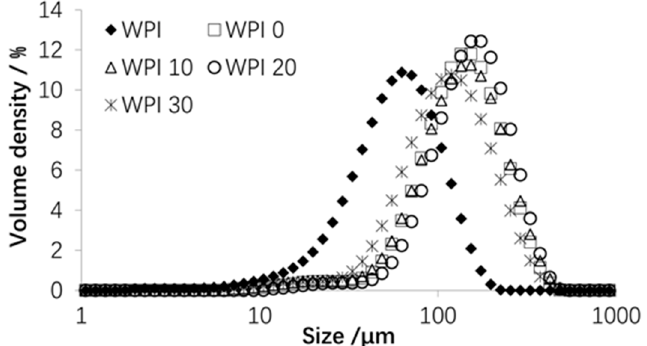
Figure 2. Particle size distributions of original and agglomerated WPI powders. Table 1. Particle size, densities and porosity of the original WPI powder (WPI) and the agglomerated